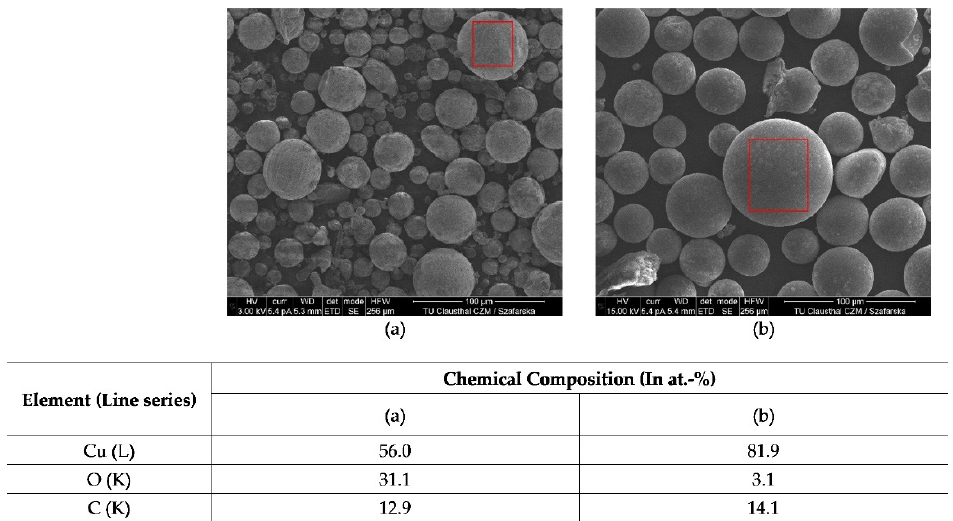
Figure 7. SEM images and the chemical composition of the copper particles created by atomisation in air and in silane-doped nitrogen. The chemical composition data were gathered via an EDS analysis with a 15 kV acceleration voltage. The spots used for analysis are highlighted by red boxes.